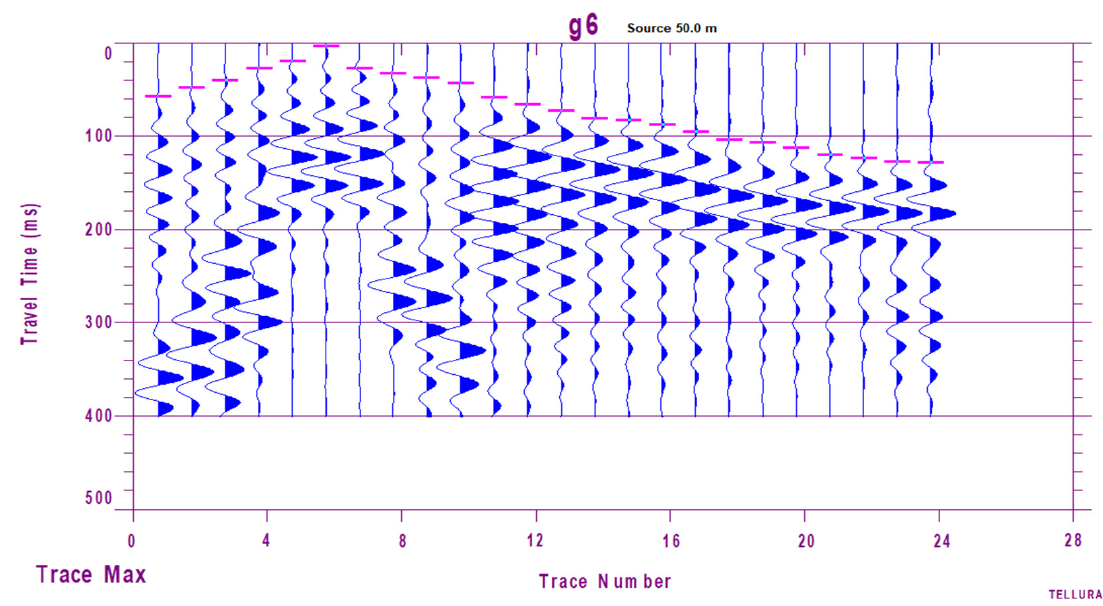
Figure 4. Example of first P-wave arrivals of the exploratory seismic tomography survey (profile Seis_1, see Figure 3) performed in the plain.